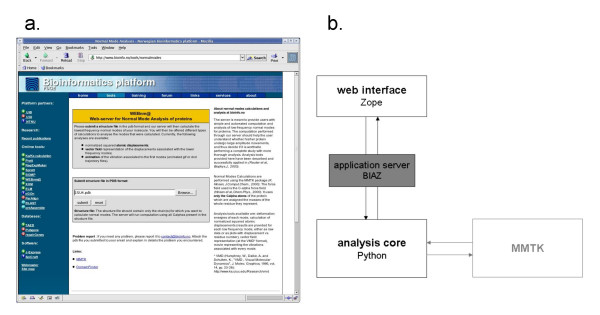
WEBnm@ architecture. a. The main page of WEBnm@ is a form where users can input a structure file in the PDB format. b. The server consists of two parts, the graphical web interface and the core of the program, written in Python, which performs the actual computation. The two parts communicate via a web application server, BIAZ.